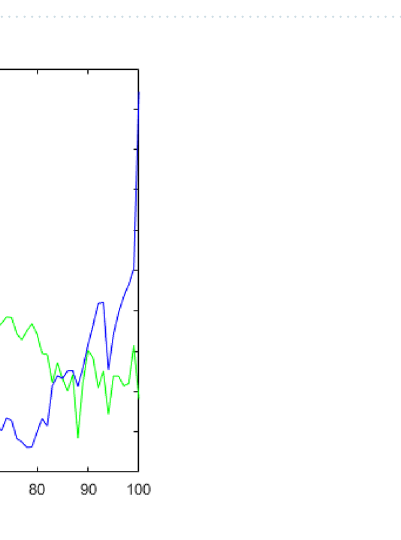
Figure 24. Fitting the curve of loss factor with five-parameter mathematical model under amplitude 0.4 mm, 0.6 mm.